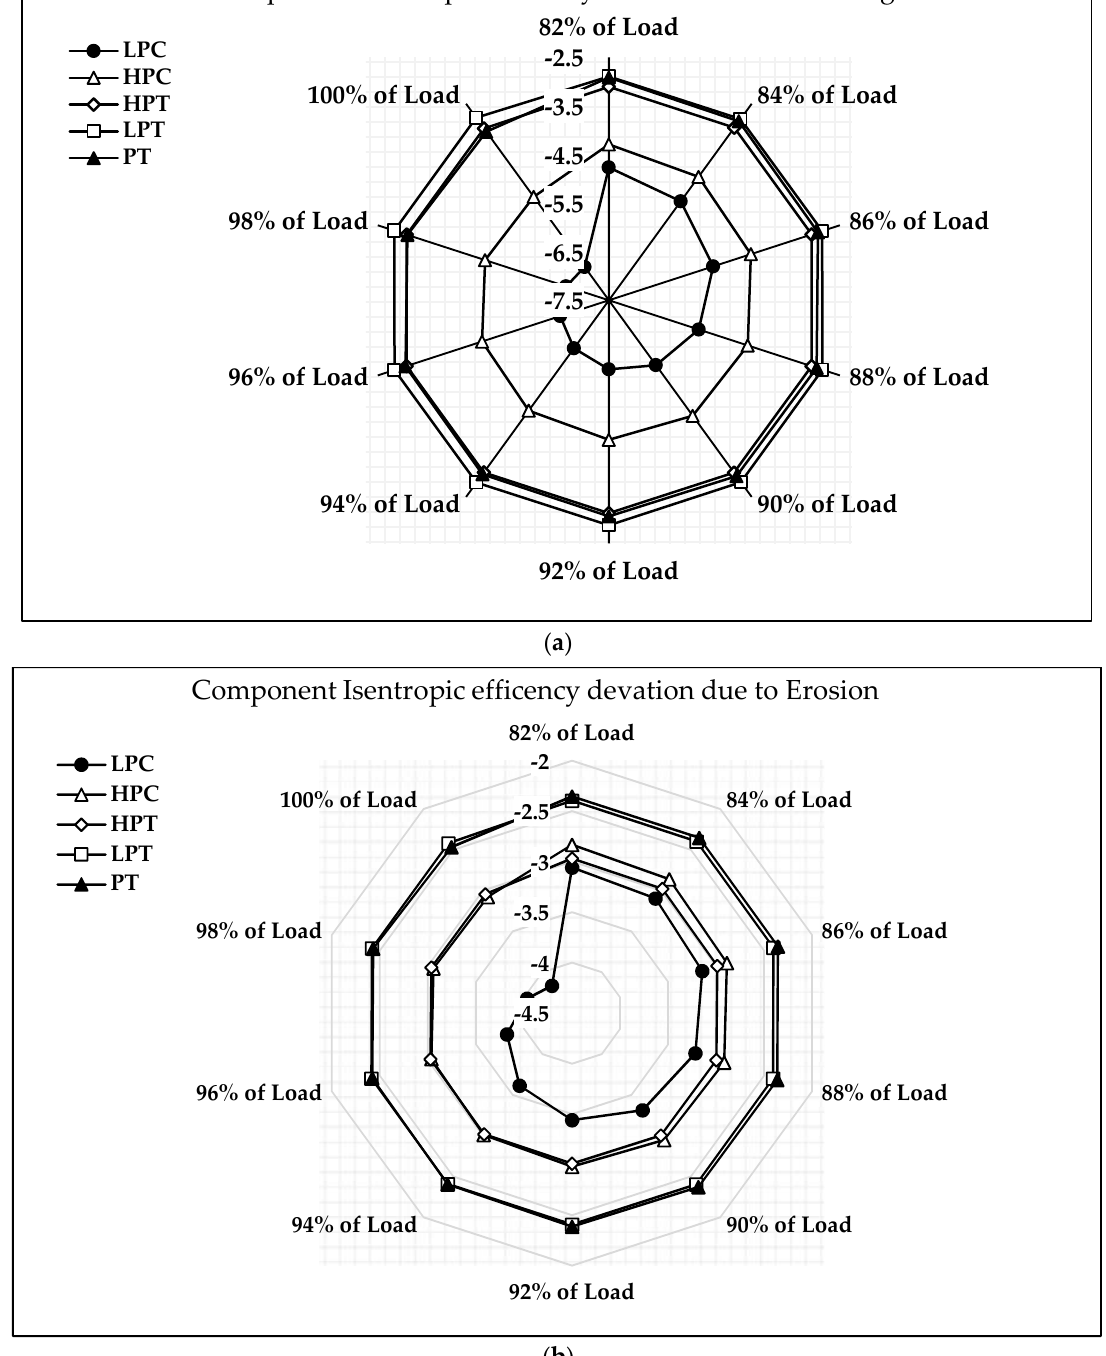
Figure 8. Deviation of component isentropic efficiency: ( a ) Fouling, ( b ) Erosion.